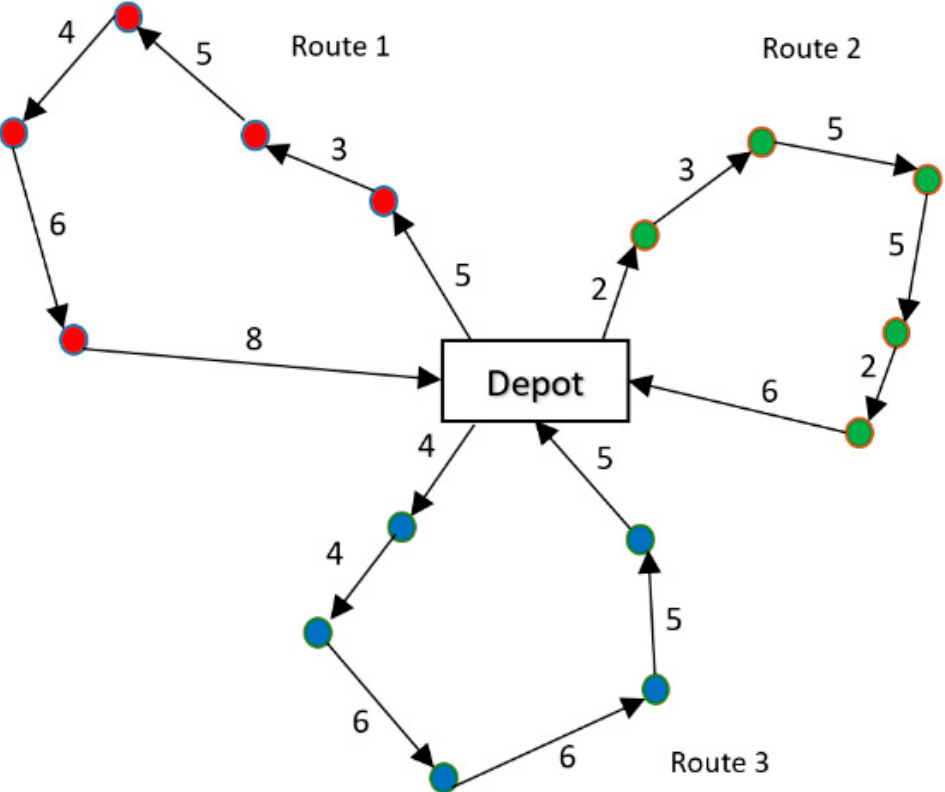
Figure 6. Sample UAV network, the numbers represent the cost units associated with each path.